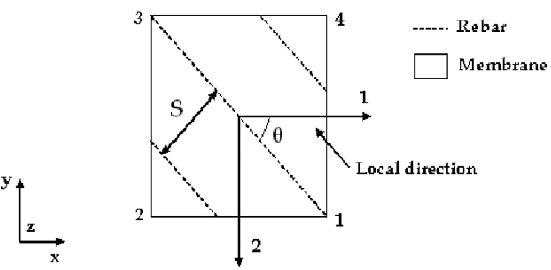
Figure 7. Rebar defined in terms of the local coordinate